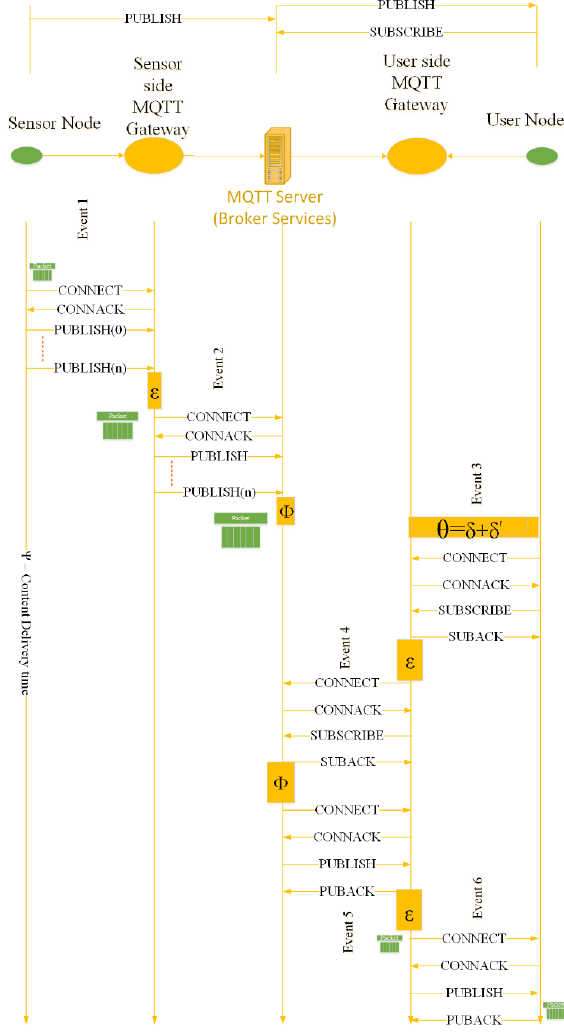
Figure 3. End-to-end delay and packet travel system model for QoS-0 retransmit Mutant